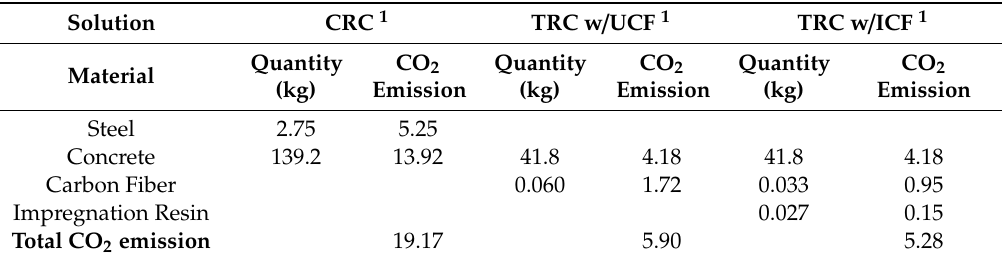
Table 8. Comparative analysis of CO 2 emissions